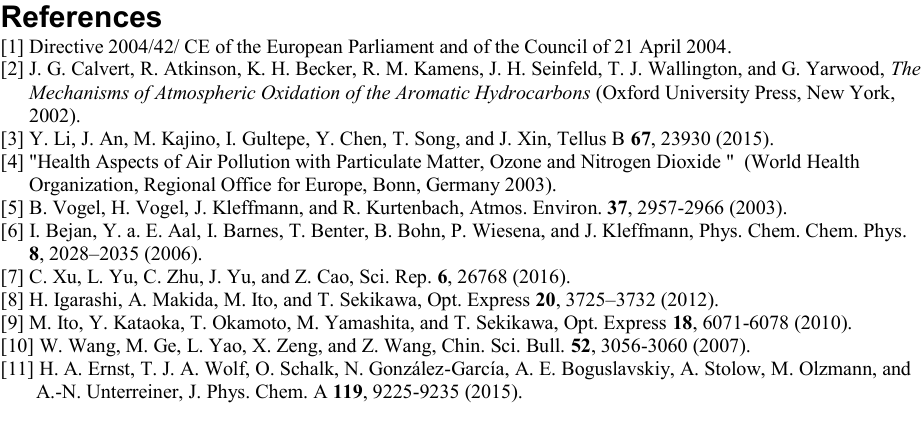
Fig. 2. a) Photoelectron spectrum of o-nitrophenol measured with a 29.5 eV pulse only (blue curve) and temporal evolution of the difference of the photoelectron spectrum from the probe-only spectrum following excitation at 400 nm (red curves). b) Difference spectrum (pump-probe minus probe only) at 1333 fs (red curve) and the photoelectron spectrum of HONO taken from Ref. [10] (blue line). c) Temporal evolution of the HONO band at 12.2 ( ● ) and at 11 eV ( ▲